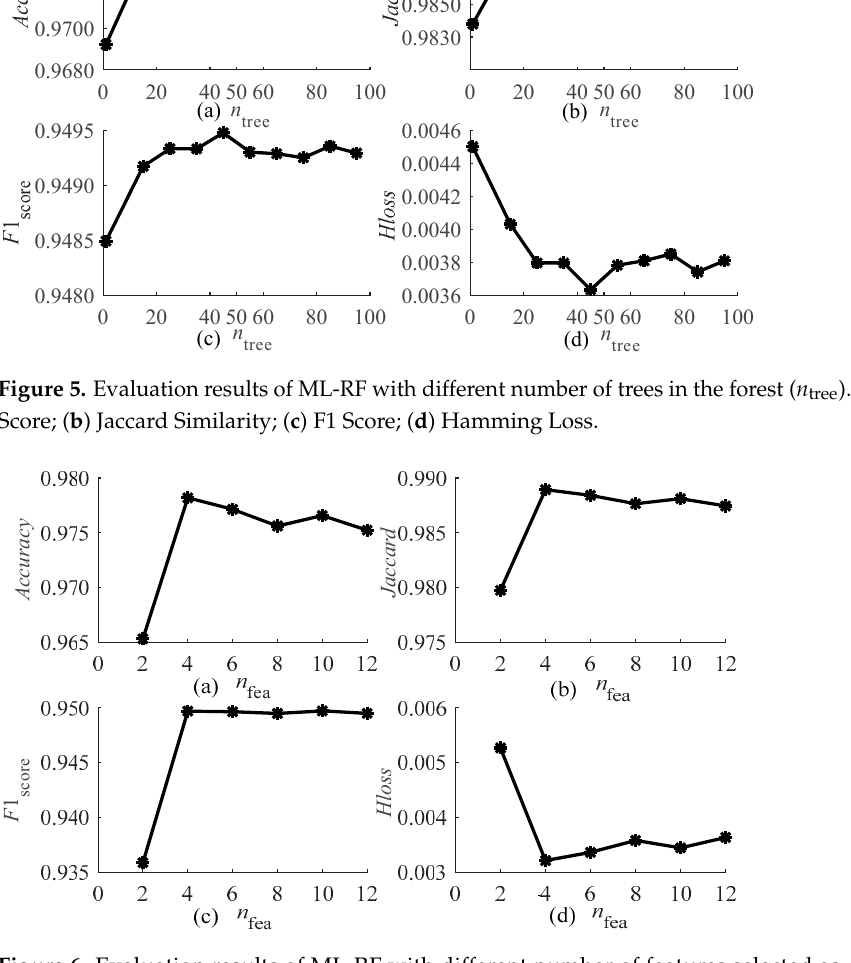
Figure 7. Evaluation results of ML-RF with different maximum depth of tree ( m dep ). ( a ) Accuracy Score; ( b ) Jaccard Similarity; ( c ) F1 Score; ( d ) Hamming Loss. 4.2.2. Performance for Test Data Set Based on the optimal ML-RF model, two sections of long and steep downgrades with a length of 29 km and 44 km, called scenario 1 and scenario 2, are chosen for the model testing. In scenario 1, there is one neutral zone, located in an area of 22.46 km to 22.98 km. In scenario 2, two neutral zones are included, located in an area of 15.90 km to 16.42 km, and 39.76 km to 40.29 km. The testing results are as follows. Three famous algorithms, multi-label Adaboost (ML-Adaboost), multi-label support vector machine (ML-SVM), and multi-label knearest neighbor (ML-KNN), are used for comparison. Tables 2 and 3 show the performance of the four algorithms. The results show that the multi-label classification algorithm based on RF, i.e., ML-RF, has the best perfor- mance on control strategy prediction.